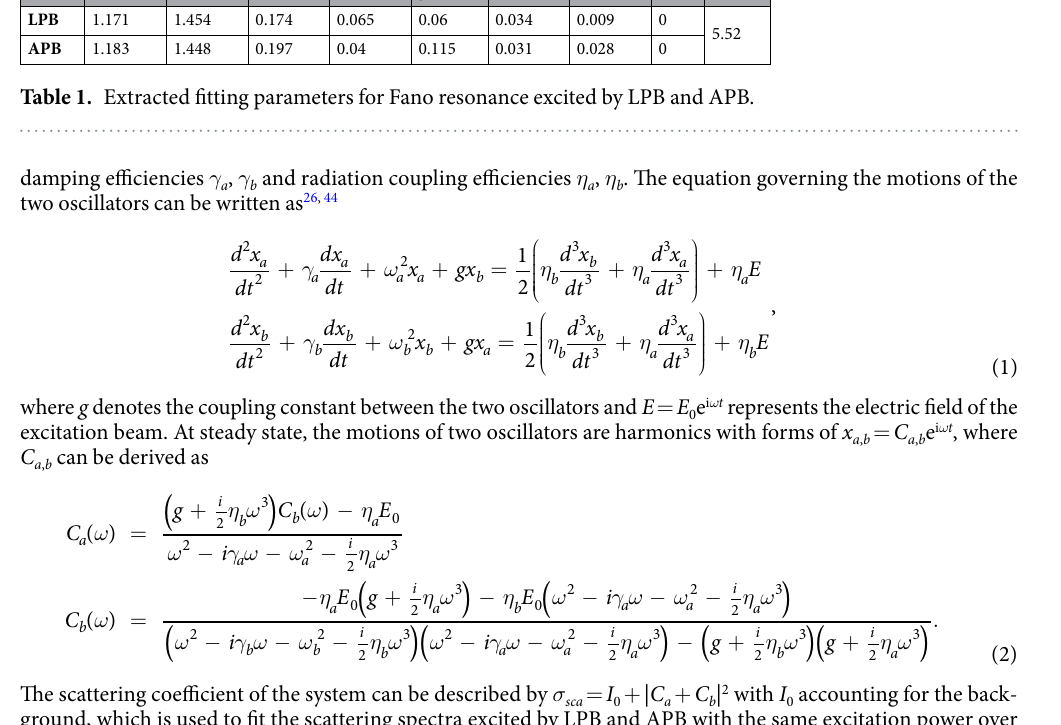
Figure 4. Scattering spectra of SRR-nanoarc structure excited by ( a ) LPB and ( b ) APB, where the black dots and red solid curves are the simulation and fitting results, respectively. The intensity distributions of the corresponding ( c ) anti-bonding and ( d ) bonding modes under the excitation of LPB (left) and APB (right), respectively. ω a ω b γ a γ b g η a η b LPB